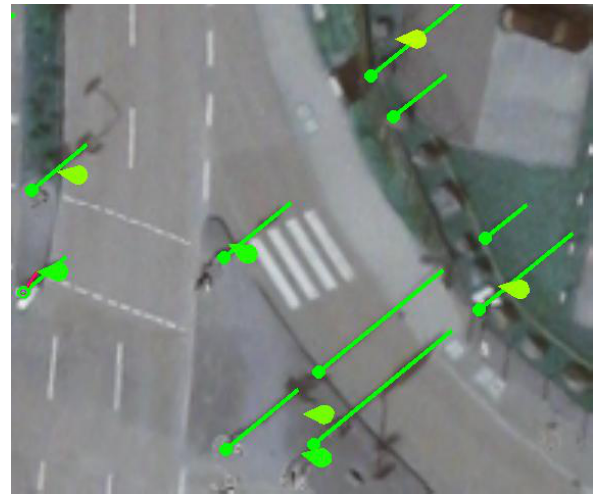
Figure 14. Section 57 × 48 m 2 from fig. 8, poles (green), radar GCPs (green to yellow drops) and the final shift (red line at lower left pole)